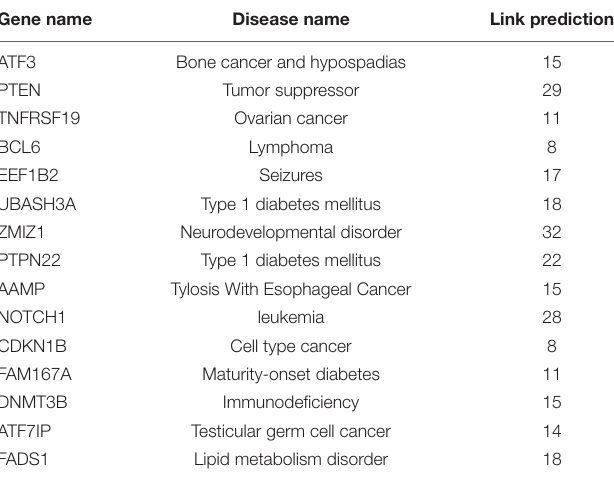
TABLE 3 | New muscle atrophy gene disease associations predicted by random walk network measure and